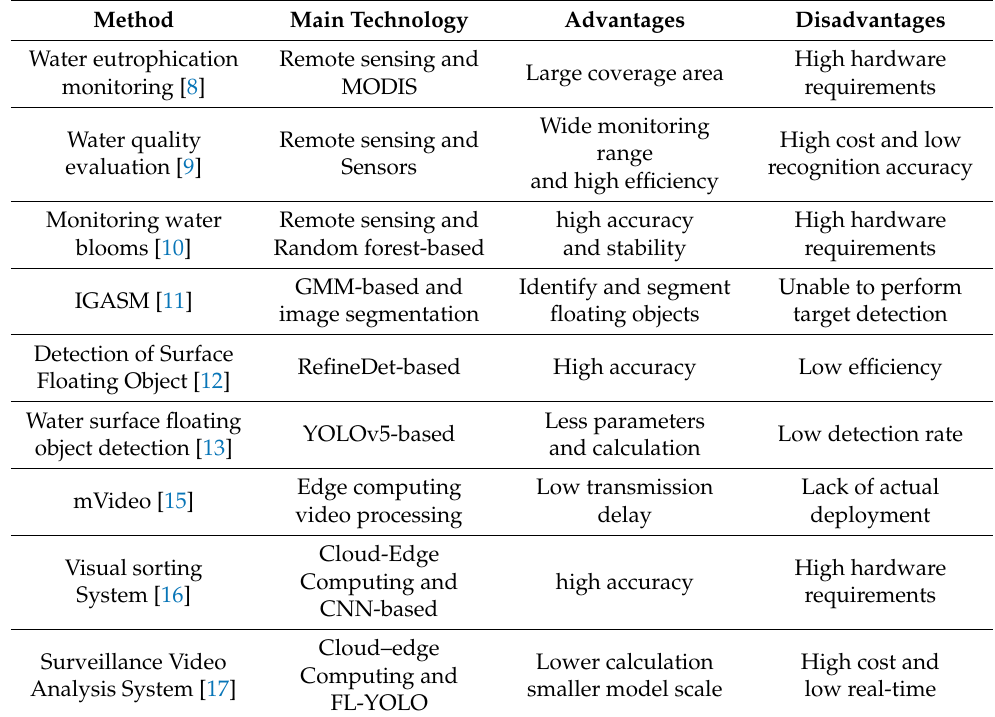
Table 1. The main work related to floating